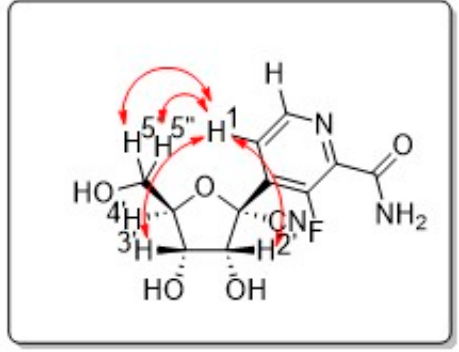
Figure 4. 1 H- 1 H NOESY correlations. Figure 4. 1 H ‐ 1 H NOESY correlations. Figure 4. 1 H ‐ 1 H NOESY correlations. Figure 4. 1 H ‐ 1 H NOESY correlations.